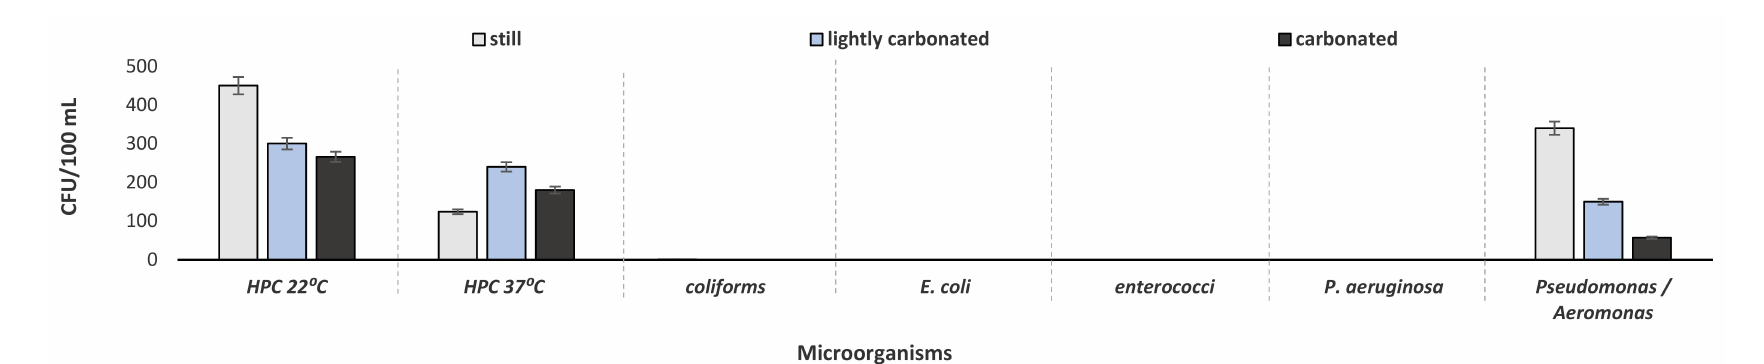
Figure 2. Bacteriological analysis of processed water.